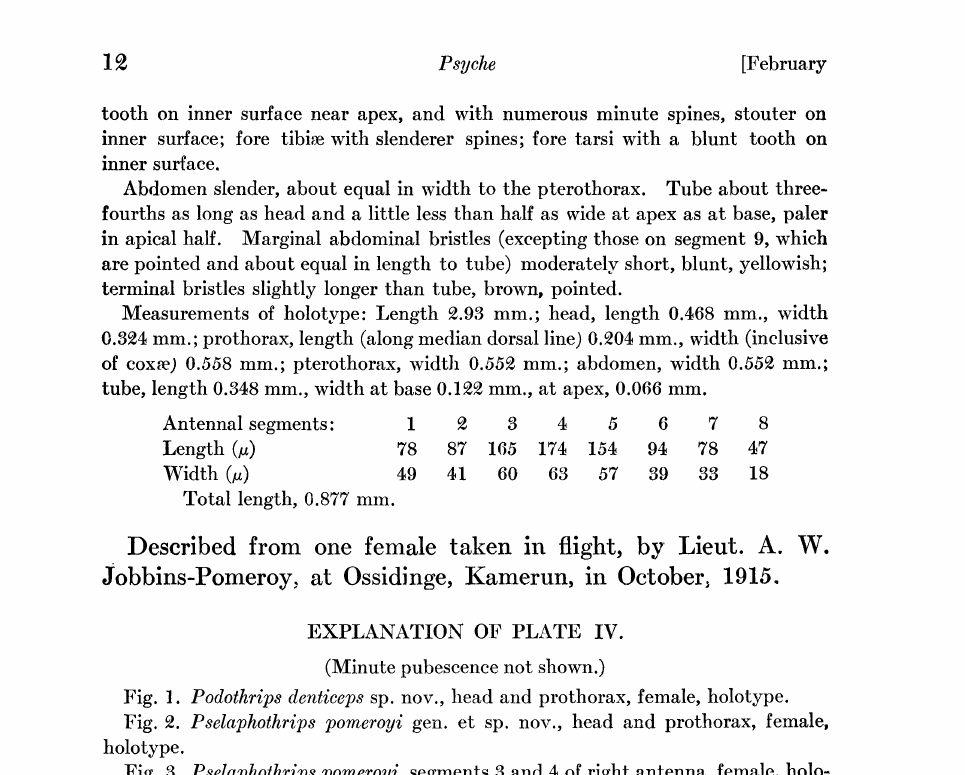
. Fig. 1. Podothrips denticeps sp. nov., head and prothorax, female, holotype. Pselaphothrips pomeroyi gen. et sp. nov., head and prothorax, female, Fig. holotype. Fig. 3. Pselaphothrips pomeroyi, segments 3 and 4 of right antenna, female, holo- type. Fig. 4. Phlceothrips coriaceus Haliday, segments 8 and 4 of right antenna, female. Fig. 5. Acanthothrips albivittatus Hood, segment 8 of right antenna, female. Fig. 6. Acanthothrips magnafemoralis Hinds, segment 3 of right antenna, female. Fig. 7. Acanthothrips nodicornis Reuter, head,